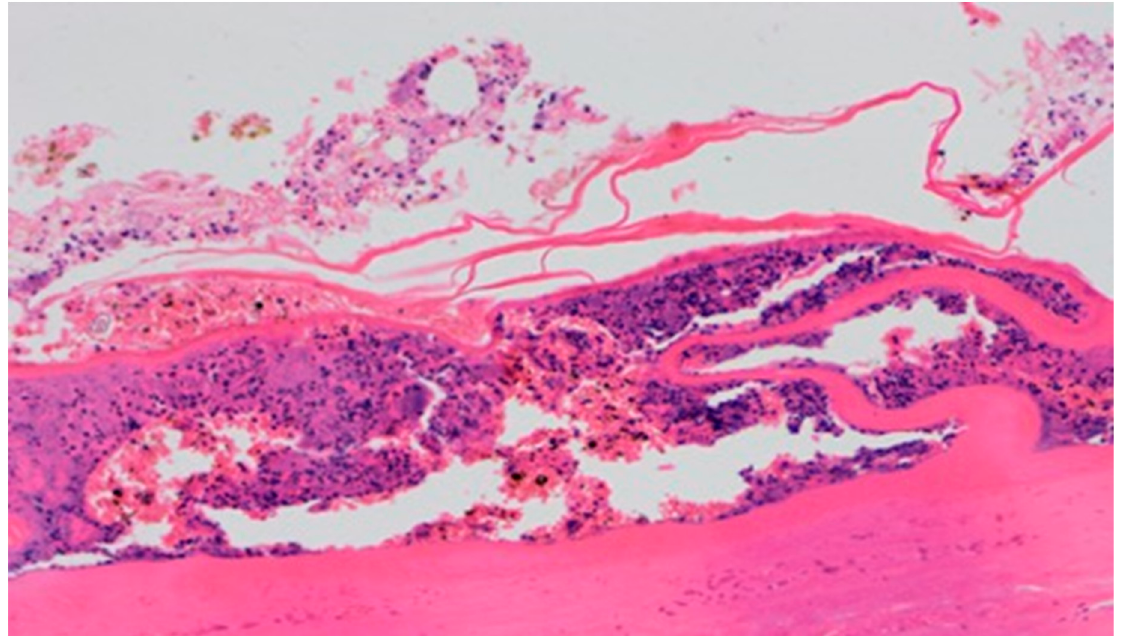
Figure 14. Necrosis, with granulocytic inflammatory infiltration (100×, H-E), in the wound treated with sulfathiazole, on day 5.